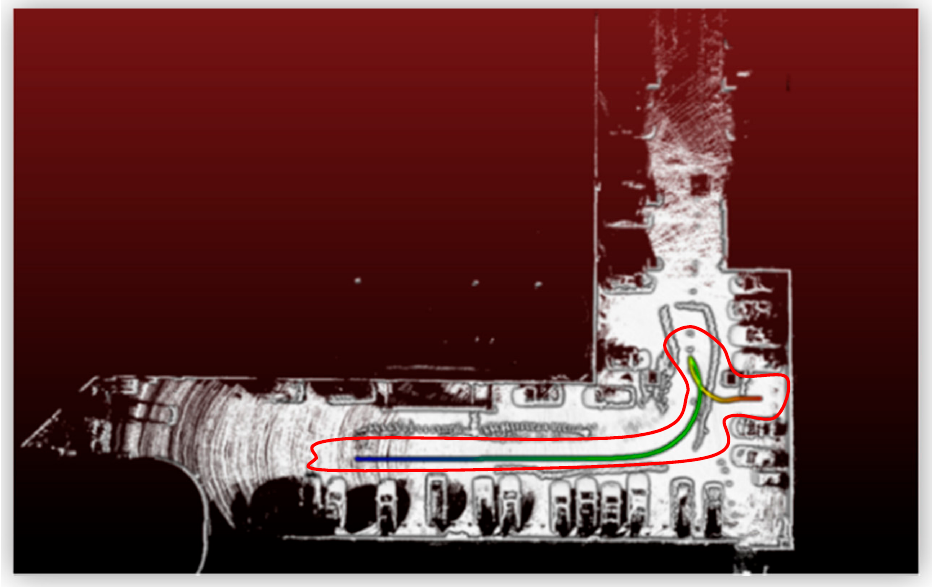
Figure 13. Indoor experiment environment.